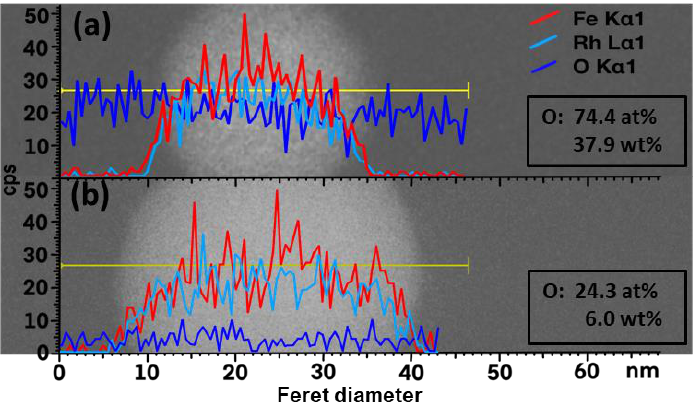
Figure 3. EDX line-scan of single Fe 50 Rh 50 nanoparticles obtained by laser ablation in acetone ( a ) with the use of a mole sieve, and ( b ) without the use of a mole sieve.